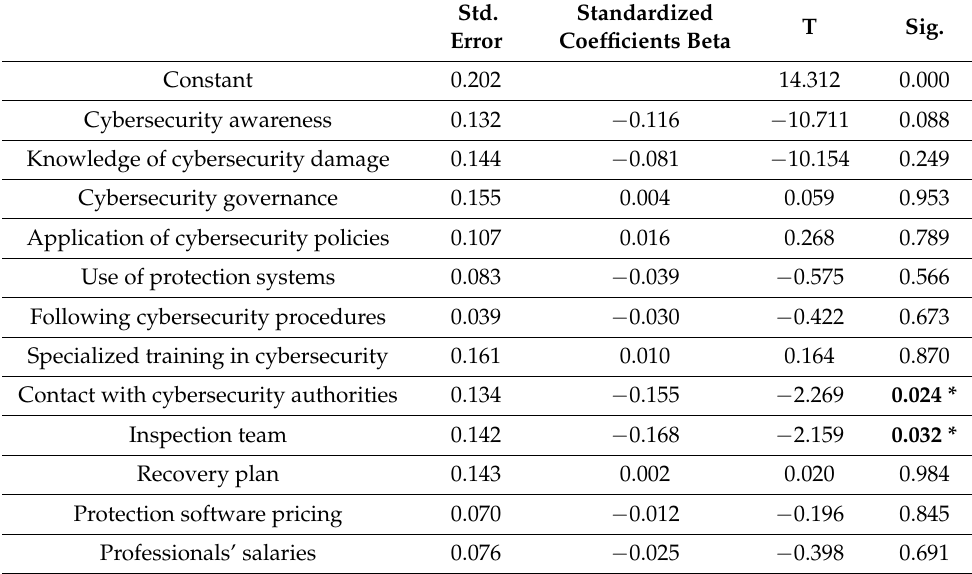
Table 9. Model coefficients (restoration